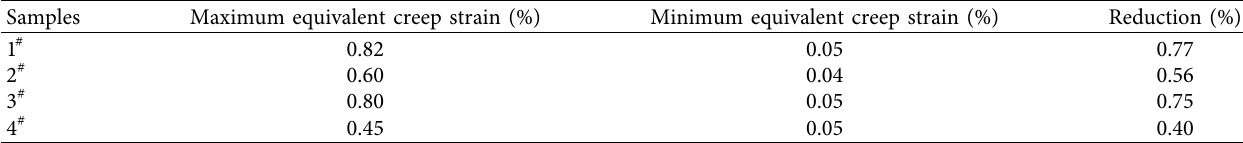
Table 4: Comparison of equivalent creep strains on observation lines of Ti-6Al-4V alloy at diferent forging temperatures.